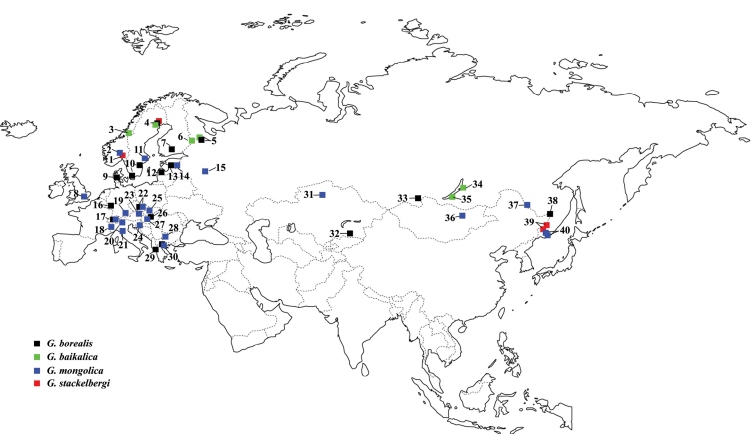
Known records of European Greenomyia species. Greenomyia borealis (black squares): 4 original data 5 Polevoi 2000 (marked with a question mark) 7 Chandler 2005 9 Chandler 2005 10 Kjærandsen et al. 2007, original data 12 Lackschewitz 1937 13 original data from two localities 16 Winnertz 1863 17 Chandler 1998, 2005 (doubtful) 22 Ševčík and Košel 2009 26 Ševčík and Papp 2001 29 Chandler et al. 2006 30 original data 32 Zaitzev 1982, 1994 33 Zaitzev 1982, 1994 38 Zaitzev 1982, 1994. Greenomyia baikalica (green squares): 3 Gammelmo and Søli 2006 4 Kjærandsen et al. 2007 5 Polevoi 2000 (three different localities) 6 Polevoi 2001 34 Zaitzev 1994 35 Zaitzev 1994. Greenomyia mongolica (blue squares): 2 Søli et al. 2009 8 Chandler 2010 (seven different localities) 11 Kjærandsen et al. 2007 14 Kurina 1997 15 Zaitzev 1994 17 Matile 2002 (as Greenomyia theresae) 18 Matile 2002 (as Greenomyia theresae) 19 Caspers 1996 20 Kurina 2008a (as Greenomyia theresae) 21 original data 22 Martinovský and Ševčik 1998, Martinovský and Barták 2000 23 Plassmann 1996 24 Matile 2002 (as Greenomyia theresae) 25 Ševčík and Martinovský 1999 27 Papp 2000 (several different localities), original data 28 Bechev 1989 30 original data 36 Laštovka and Matile 1974 37 Zaitzev 1982, 1994 40 Zaitzev 1982, 1994. Greenomyia stackelbergi (red squares): 1 Søli and Kjærandsen 2008 4 Kjærandsen et al. 2007 39 Zaitzev 1982, 1994.